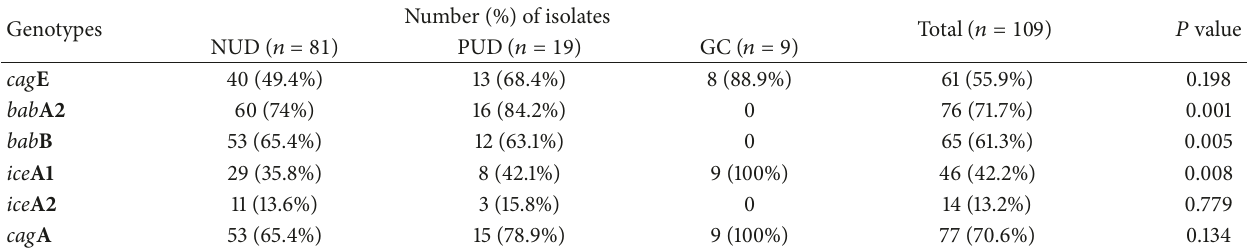
Table 2: Relationship between clinical outcome and status of cag E , bab A2 , bab B , ice A1 , ice A2 , and Cag A .